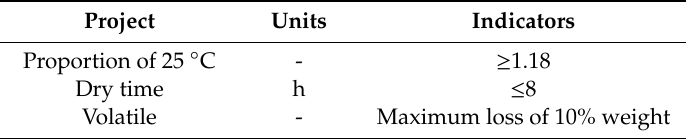
Table 3. Physical properties of Sand-fog seal material.